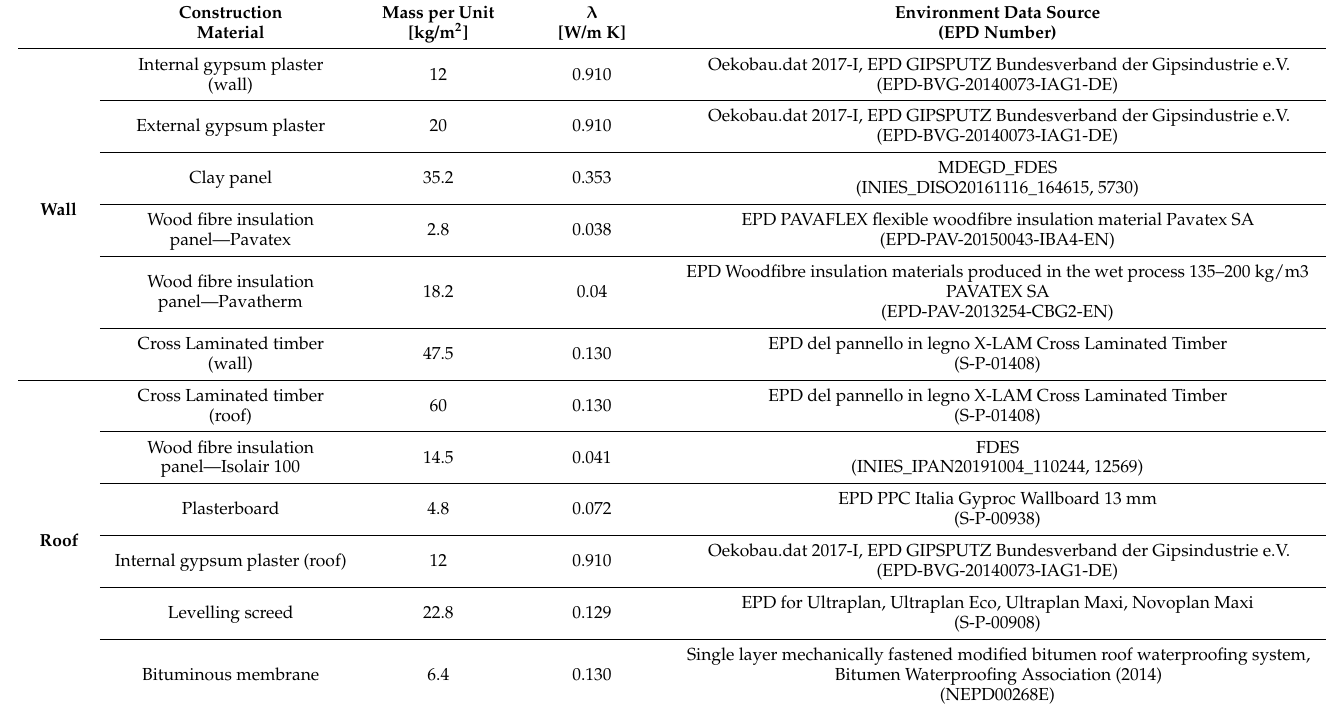
Table 9. Bill of material, thermal conductivity and data source: CLT configurations for 1 m 2 of wall and